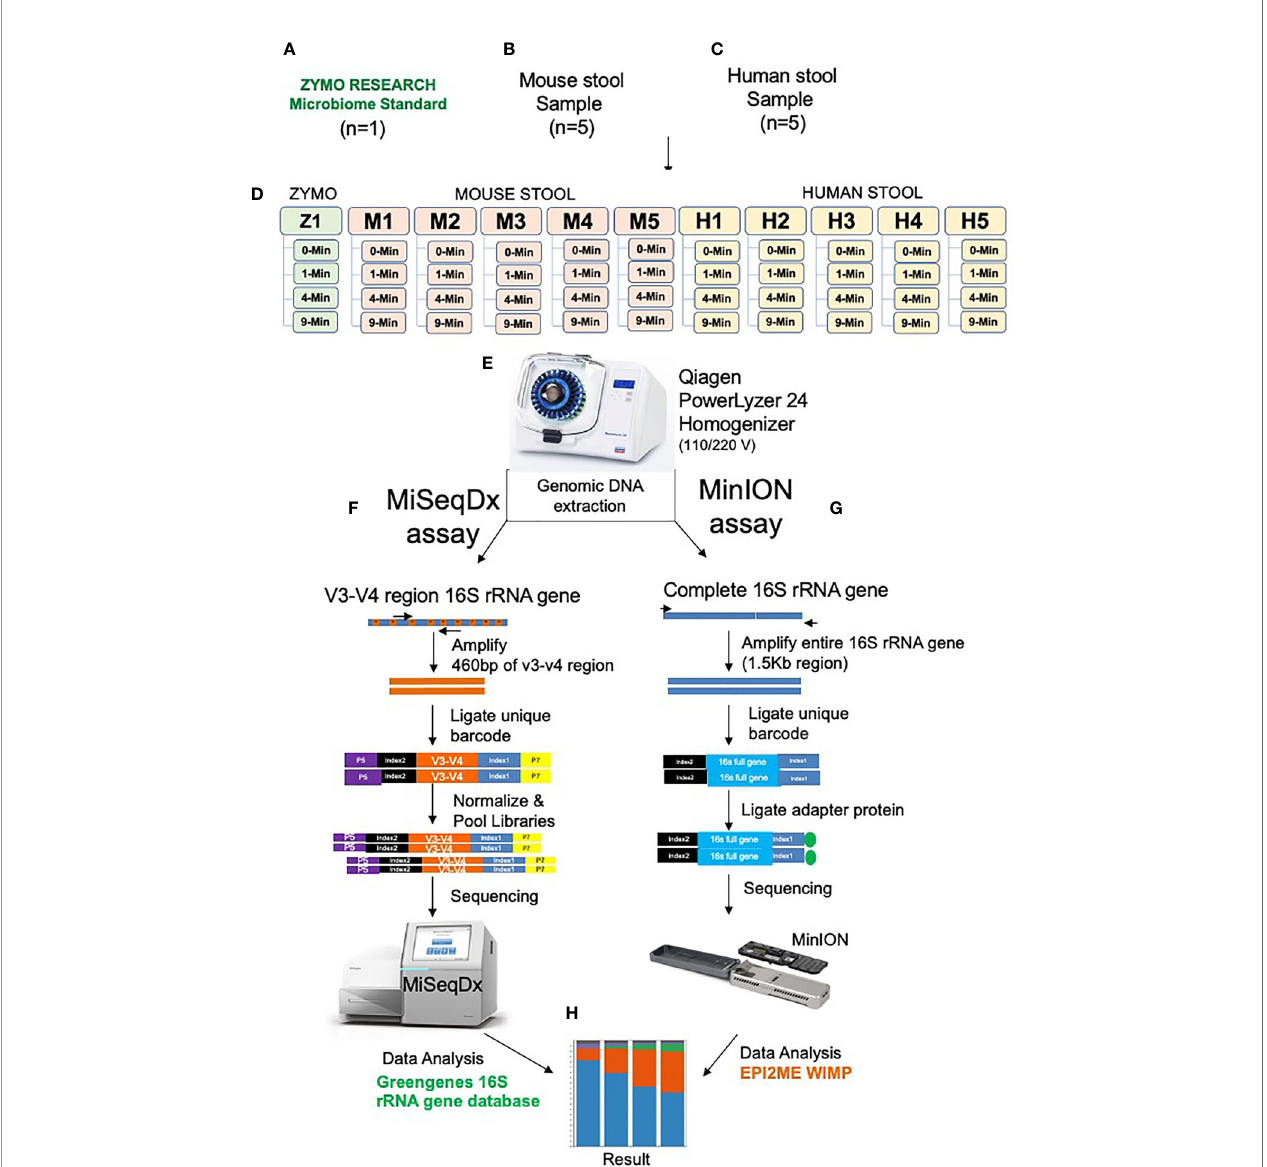
FIGURE 1 | Illustration of the experimental design and work fl ow. One Zymo human gut microbiome mock control D6331 (A) , Five mouse stool samples (B) , Five human stool samples (C) , Experiment design (D) , PowerLyzer 24 Homogenizer used for homogenization (E) . Gut microbiome sequencing using V3-V4 16S rRNA amplicon method on MiSeq, Illumina (F) , Full length 16S rRNA gene sequencing on MinION, Oxford Nanopore (G) and OTU clustering analysis (H)